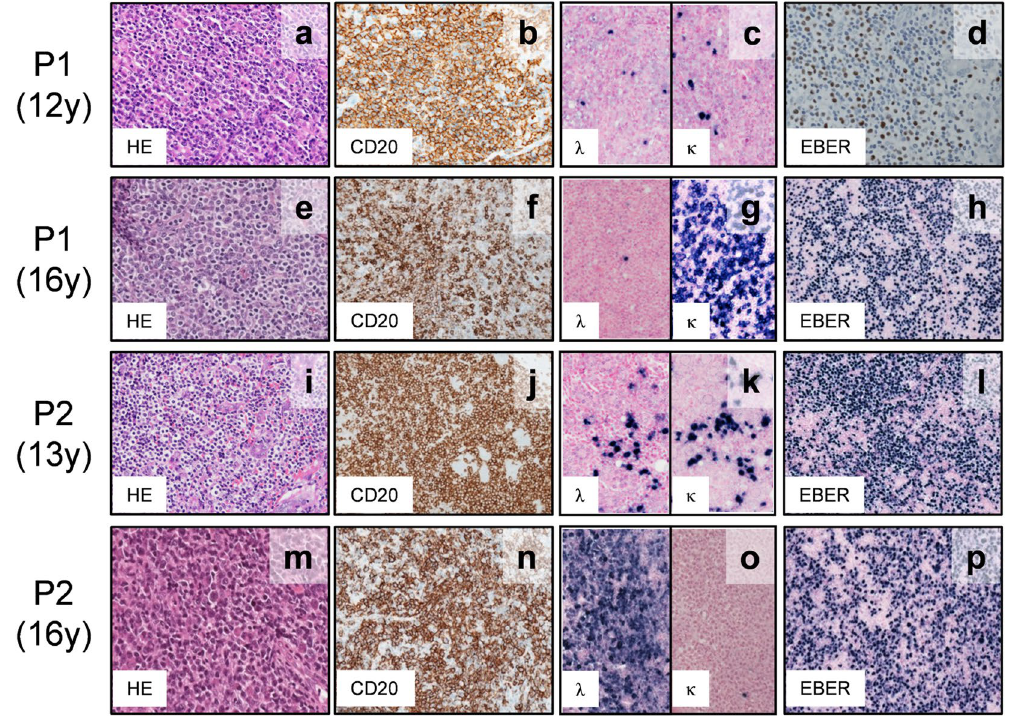
Figure 2. Histologic analysis of biopsy specimens from the patients. A biopsy specimen from the parotid gland of P1 at 12 years of age ( a–d ) and at 16 years of age ( e–h ). The parotid gland of P2 at 13 years of age ( i–l ); the left nasopharynx of P2 at 16 years of age ( m–p ). Staining with hematoxylin and eosin (HE) and immunostaining with anti-CD20 antibody demonstrates the infiltration of CD20 + lymphocytes. An in situ hybridization study demonstrated EBV-encoded RNAs (EBERs). The cell clonality was assessed by in situ hybridization for κ and λ mRNAs.